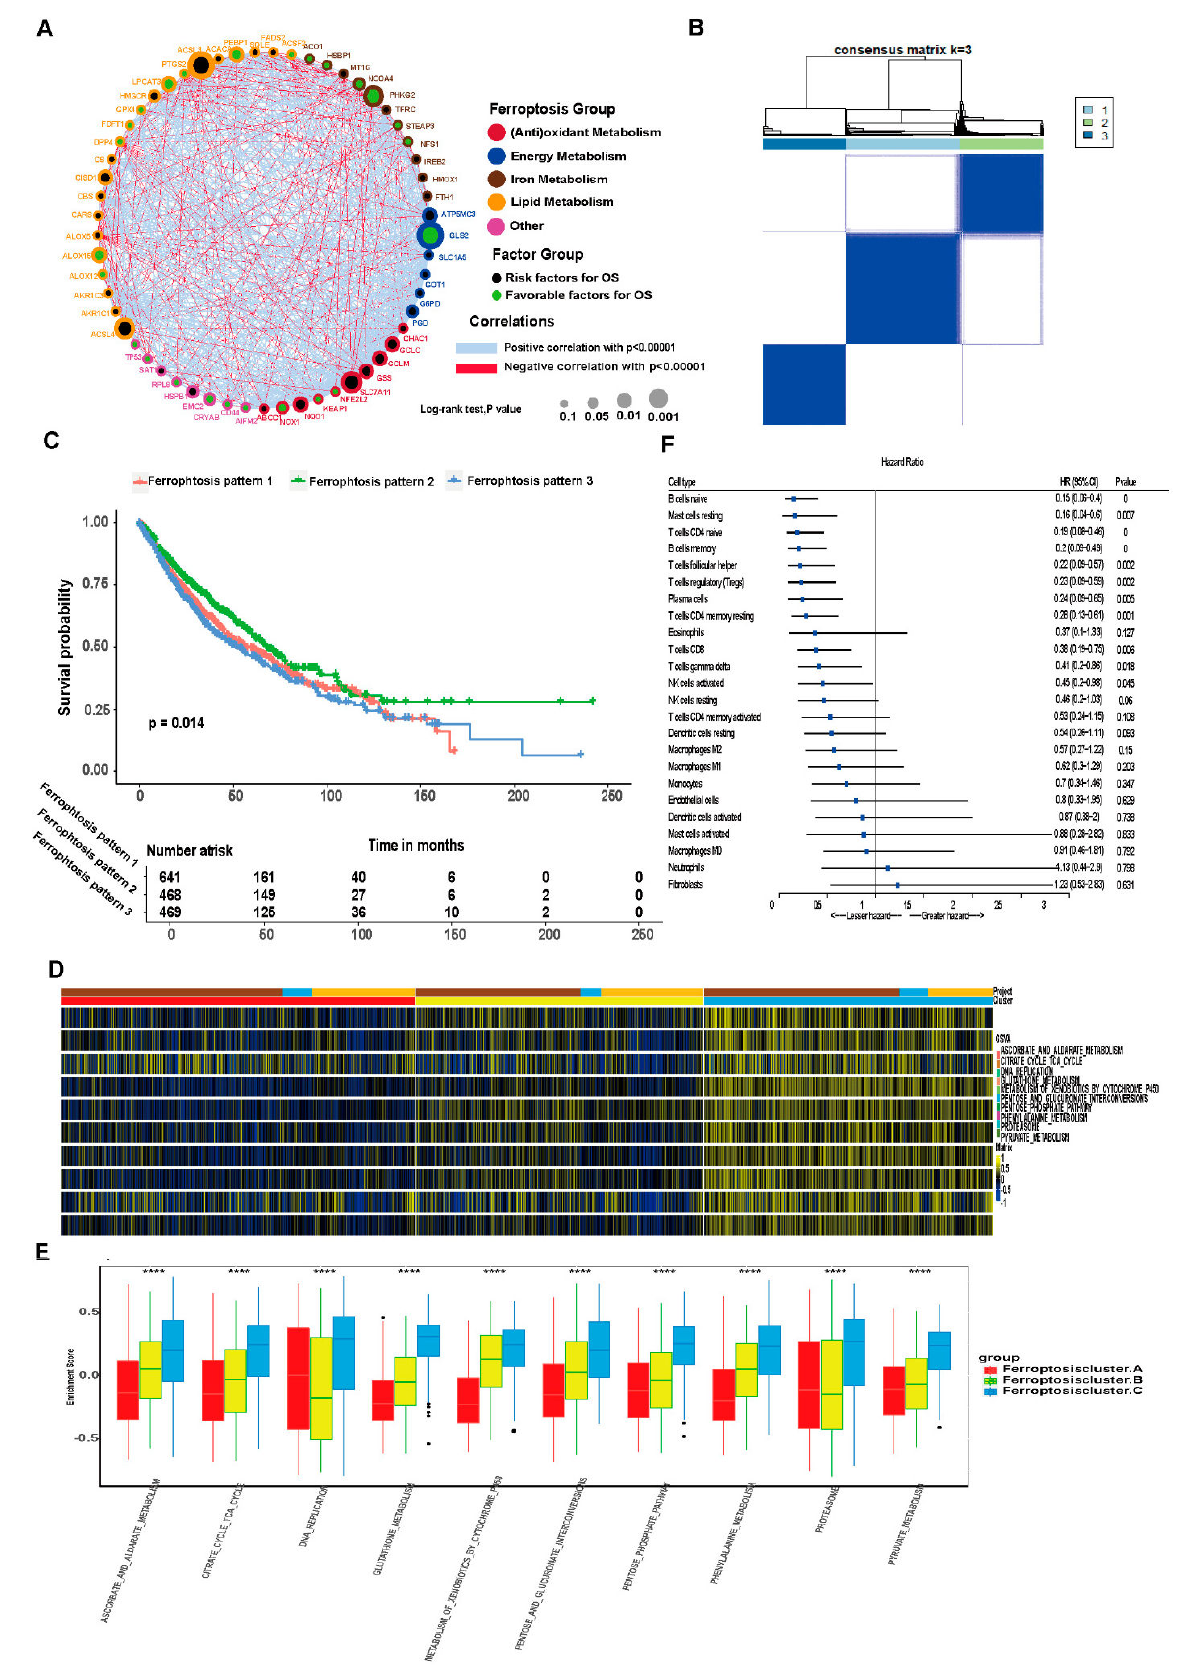
Figure 3. Unsupervised cluster analysis of ferroptosis-related genes in LUAD and LUSCC